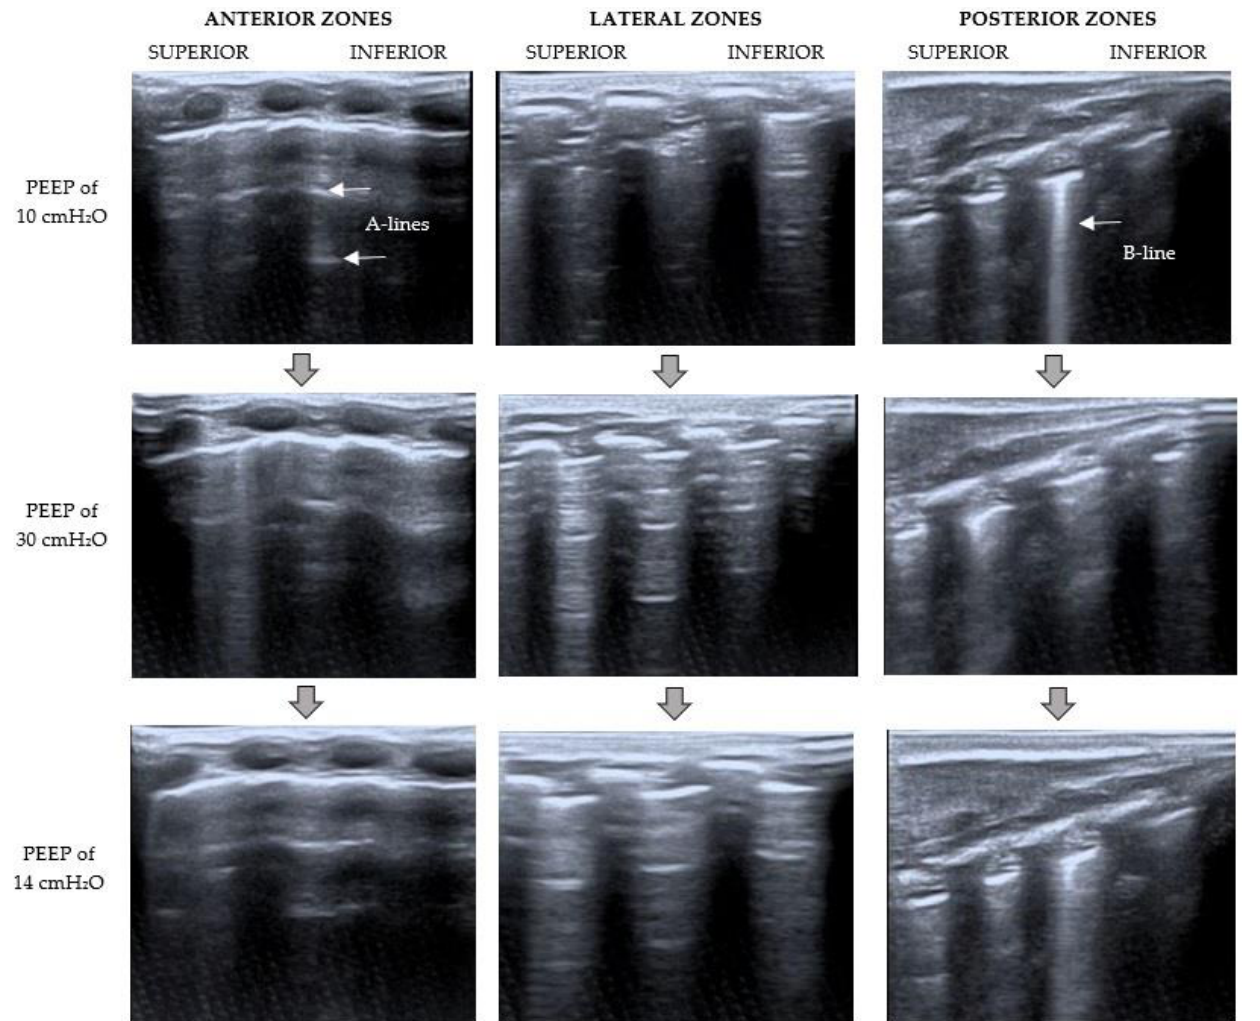
Figure 4. Right LUS examination during RMs. The point where the LUS probe is applied is indicated at the top of the figure; on the left, the PEEP level at that moment is specified. Baseline LUS (PEEP of 10 cmH 2 O) showed a B1 pattern (presence of lung sliding with A-lines and fewer than two isolated B-lines per rib interspace). With a PEEP of 30 cmH 2 O, the pattern changed from B1 to N (lung sliding horizontal A-lines and fewer than two isolated B-lines). After RMs (PEEP of 14 cmH 2 O), a normal aeration pattern (N) was observed.